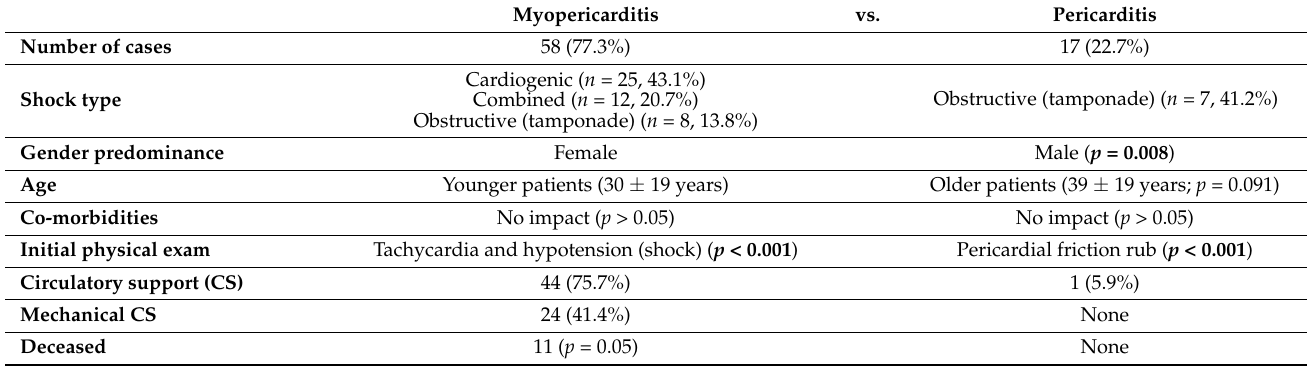
Table 2. Characteristics and comparison of myopericarditis vs isolated pericarditis cases.